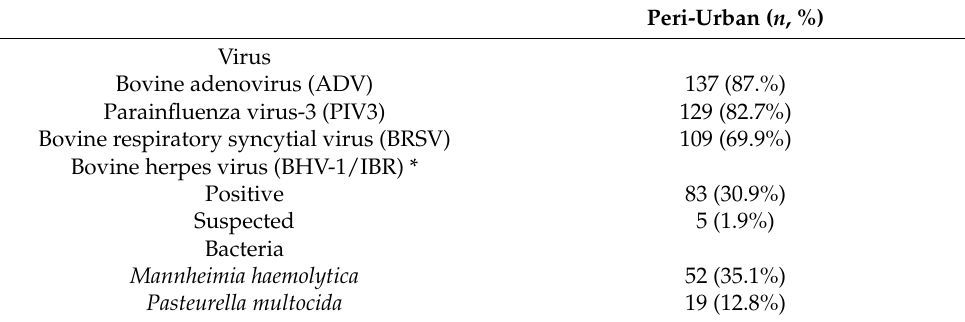
Table 8. Respiratory virus test results